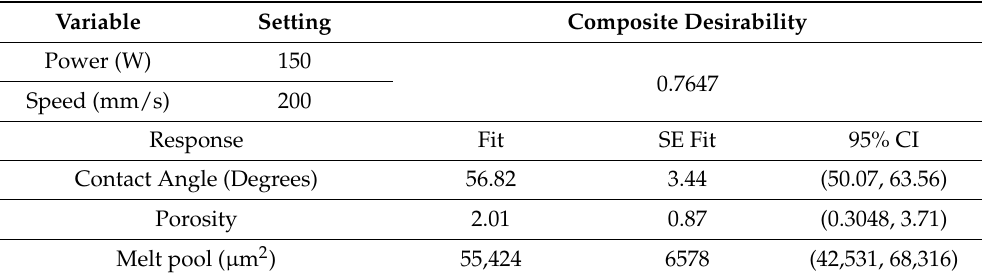
Table 7. Multiple response